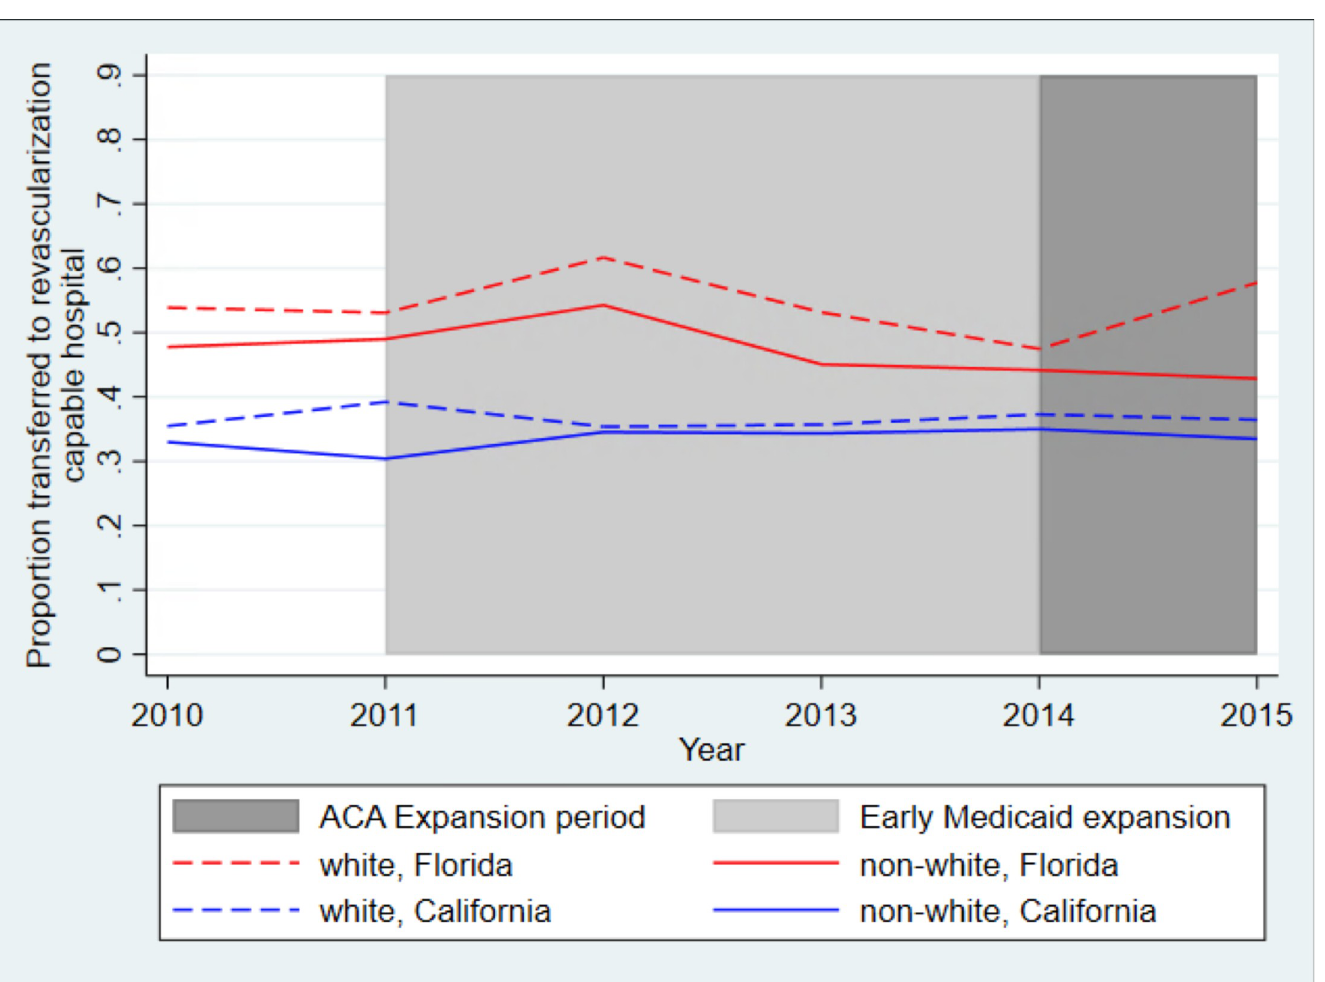
Fig 1. Unadjusted trends in likelihood of transfer to a PCI hospital in California and Florida for patients who initially presented to a non-PCI hospital, white patients and minority patients. Legend : The blue dashed line shows trends for white patients in California, the blue solid line shows trends for minority patients in California, the red dashed line shows trends for white patients in Florida, and the red solid line shoes trends for minority patients in Florida. While all California counties expanded Medicaid by January 2014, as indicated by the dark grey area of the graph, some California counties began expanding Medicaid at earlier dates, beginning as early as 2011, as indicated by the light grey area of the